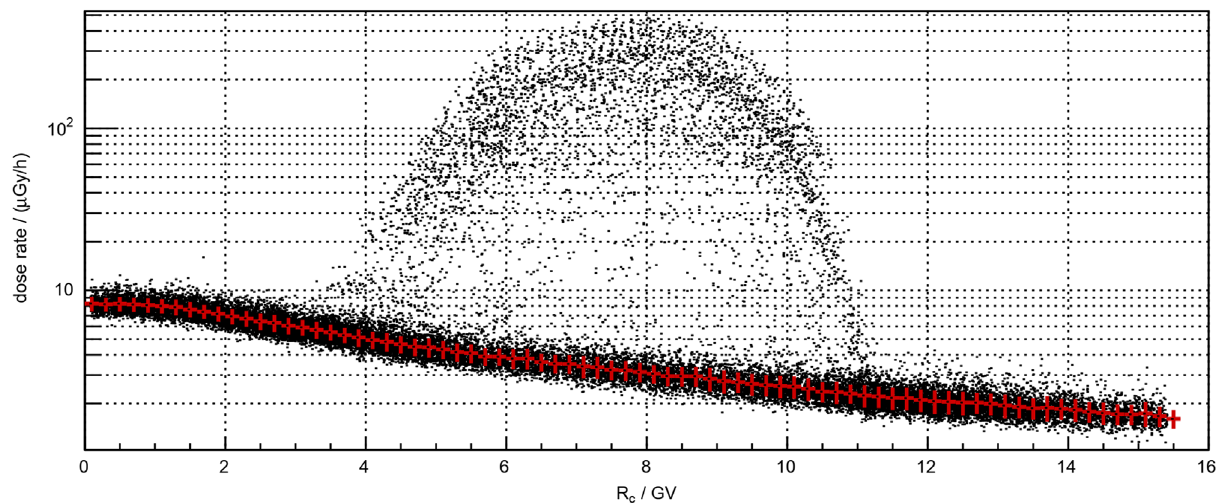
Fig. 3. DLR GCR/SAA dose rate for D3D D-1 instrument for March 2015; dose rate versus R C with the mean and standard deviation of the SAA-free subset given in